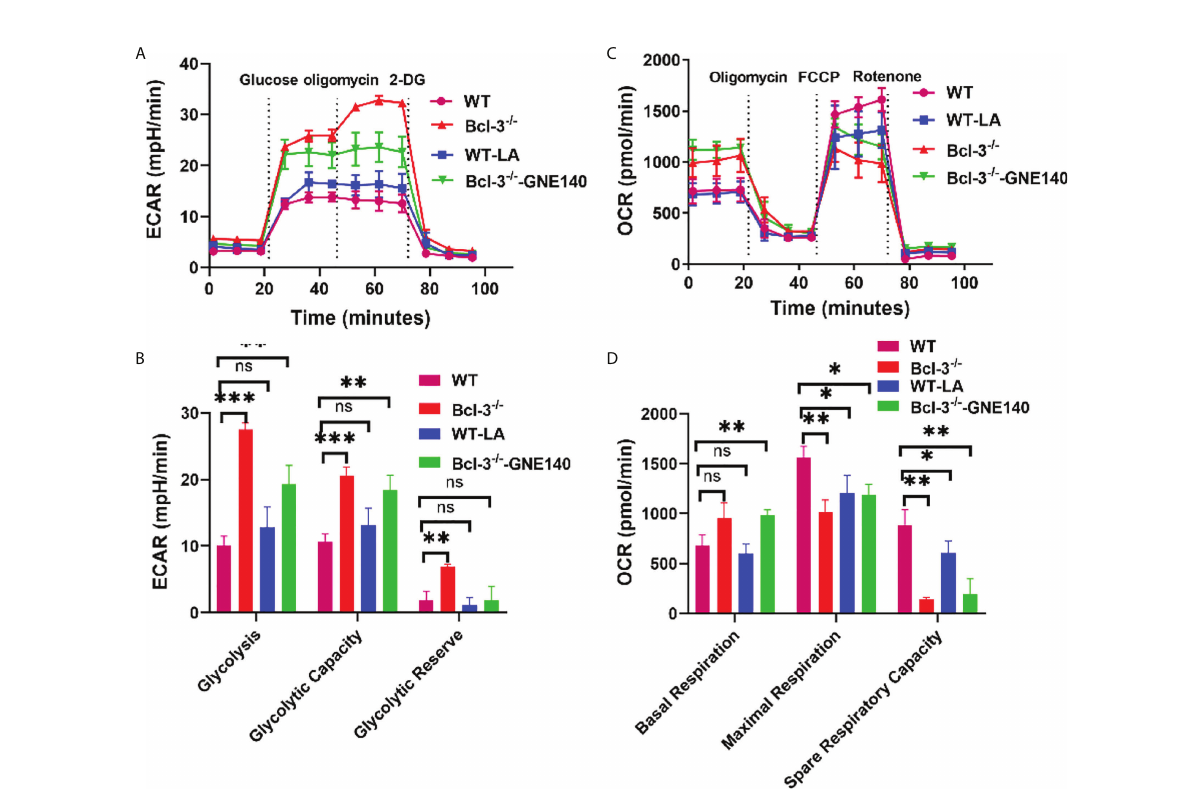
FIGURE 4 Lactate regulates the energy metabolism of Th17 in Bcl-3 -/- mice. Naïve CD4+ T cells were isolated from the spleen of Bcl-3 -/- and WT mice and induced Th17 differentiation by in vitro polarization assay, 10 m M GNE-140 was added to Bcl-3 -/- group, 25 mM lactate were added to the WT group for three days, and cells were detected the metabolic signals by seahorse XF24 extracellular fl ux analyzer. (A) Glycolytic pathway was detected by extracellular acidi fi cation rate (ECAR). (B) Statistical analysis of ECAR (C) mitochondrial respiration was detected by oxygen consumption rate (OCR). (D) Statistical analysis of OCR. n = 3 for each group. Data above are representative of 3 independent experiments. *P <0.05, **P <0.01, ***P <0.001, “ ns ” , no signi fi